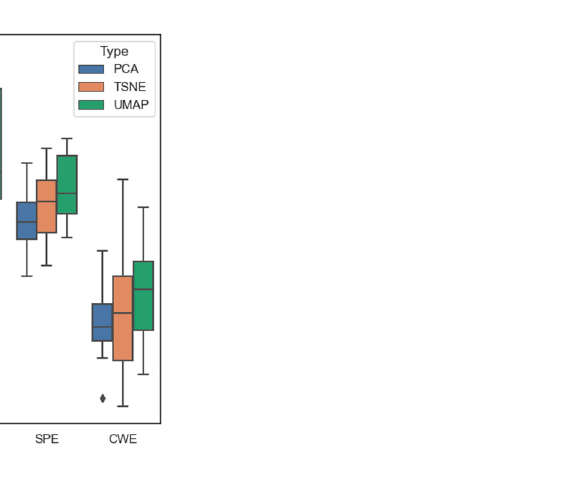
Figure 13. ( a ) Runtime of three dimensionality reduction techniques (PCA, t-SNE, and UMAP). ( b ) Data visualization after using PCA with n_components = 2, svd_solver = auto. ( c ) Data visualization after using t-SNE with n_components = 2, metric = ‘Euclidean’. ( d ) Data visualization after using UMAP with n_components = 2, metric = ‘Euclidean’. Data were obtained by using SAE on Subject 2.